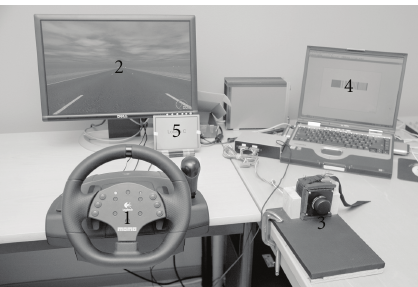
Figure 1: The figure shows the experimental setup: a steering wheel (1), a screen with a simulated highway (2), a haptic rotary device (3), a laptop used for the menu selection task (4), and a 6.4 (cid:2) display